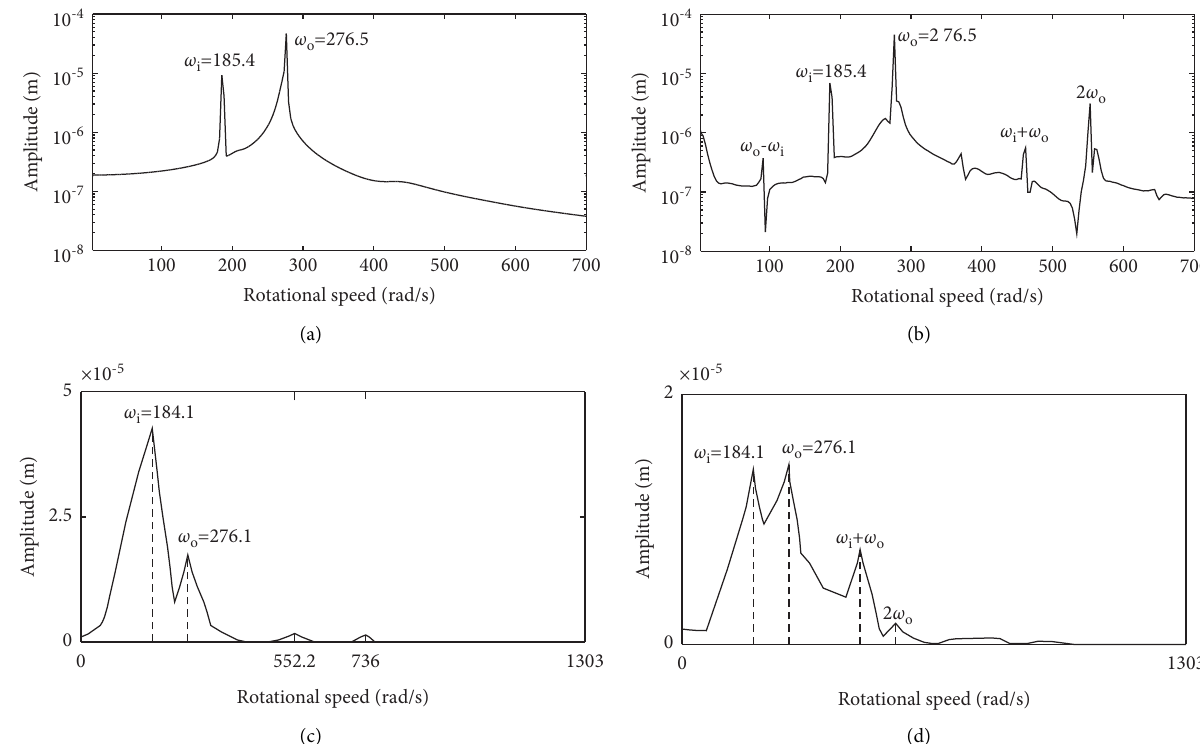
Figure 9: Response spectra diagrams of the dual-rotor system. (a) Simulation result without rubbing. (b) Simulation result with rubbing. (c) Experimental result without rubbing [15]. (d) Experimental result with rubbing